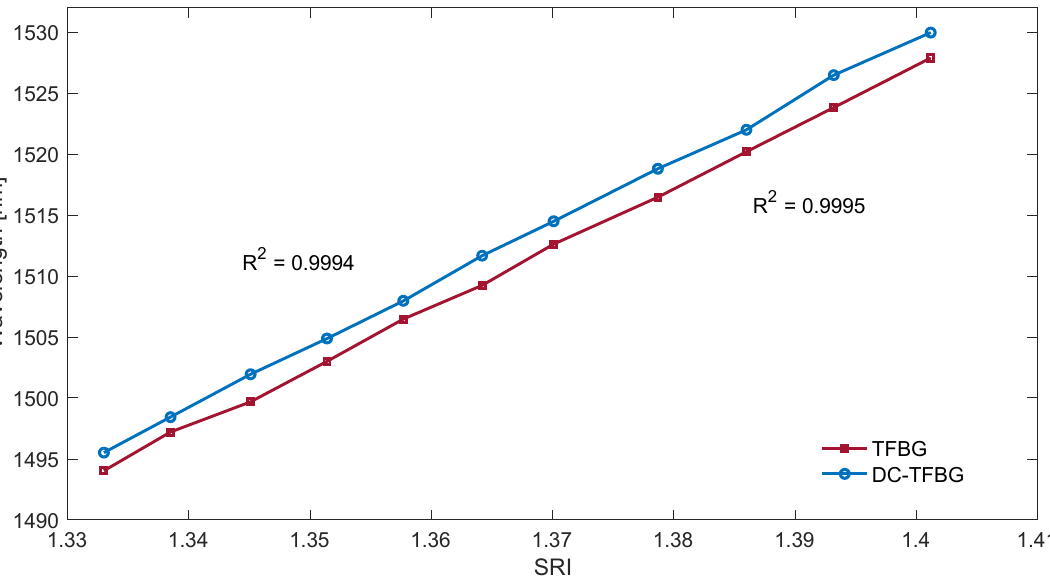
Figure 17. Second derivative of the cumulative spectrum contour for TFBG and DCTFBG.